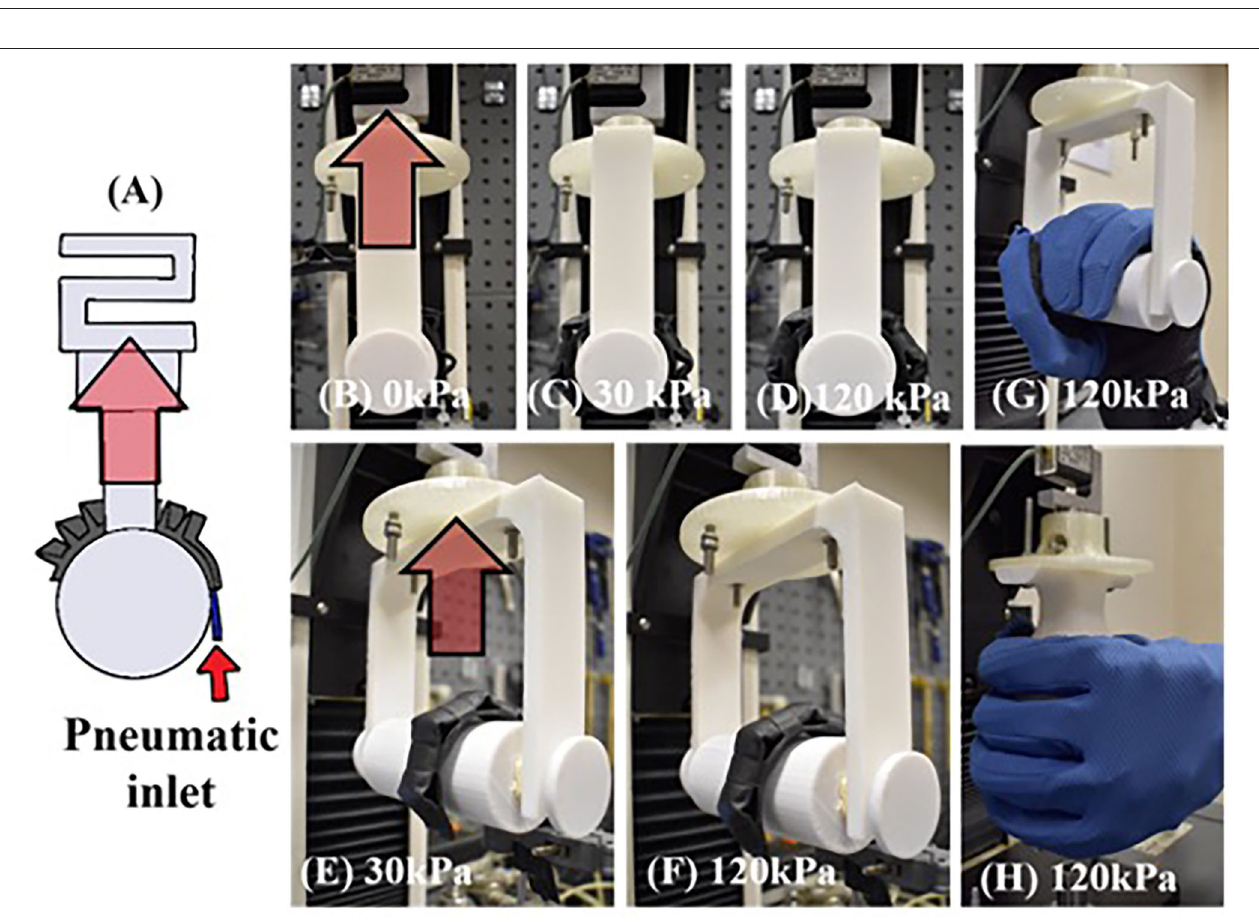
FIGURE 3 | (A) Schematic diagram of grip test. (B–F) Photo of FFA in vertical grip test and soft robotic hand in (G) vertical, and (H) horizontal grip